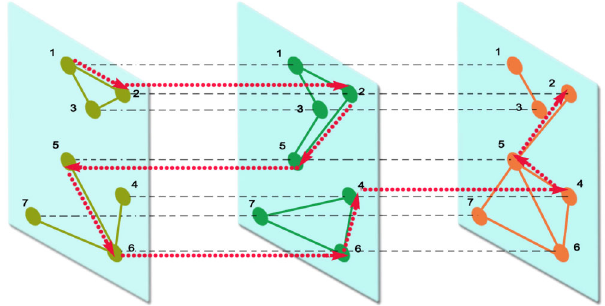
FIG. 5. Schematic of a random walk (dotted trajectories) in a multiplex network. A walker can jump between nodes within the same layer, or it might switch to another layer. This illustration evinces how multiplexity allows a random walker to move between nodes that belong to different (disconnected) compo- nents on a given